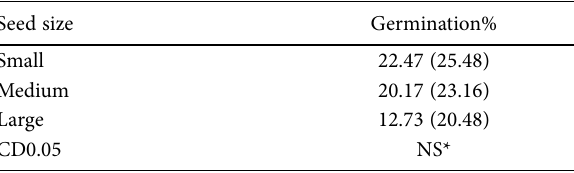
Table 11. Impact of seed size on germination